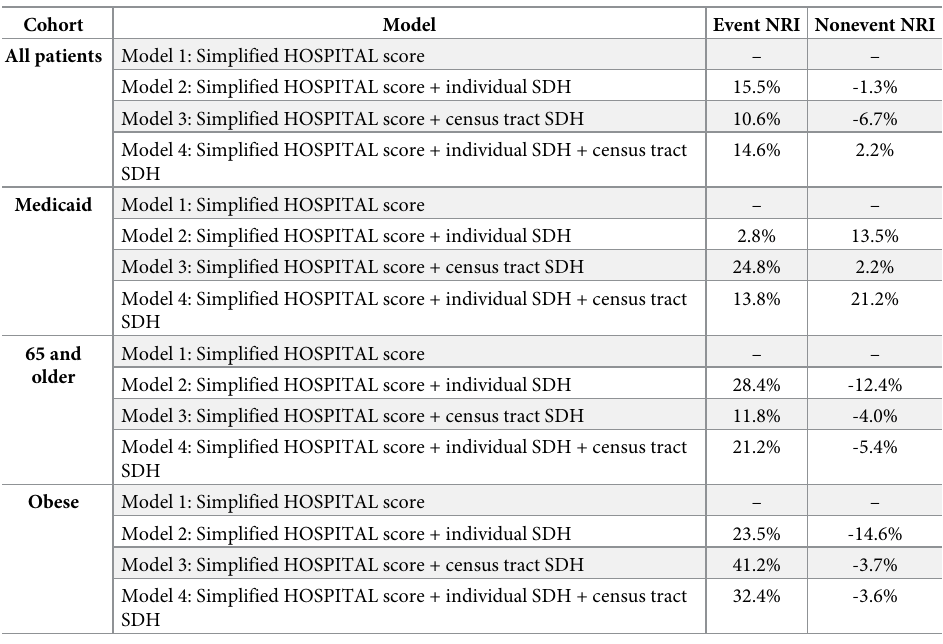
Table 4. Net reclassification improvement after adding SDH